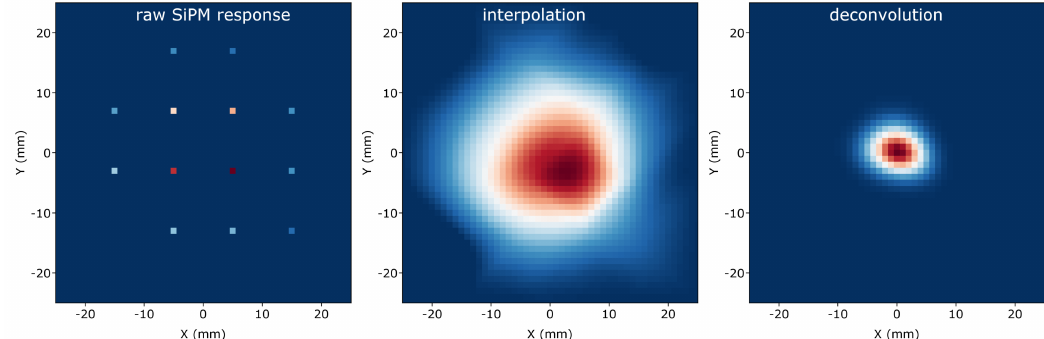
Figure 5 . Example of a reconstructed 83 m Kr event from NEXT-White data. The event is centered at (0,0) for convenience. Left: raw sensor response, with a charge cut of 10 PE. Center: bicubic interpolation. Right: deconvolved image after 75 RL iterations.